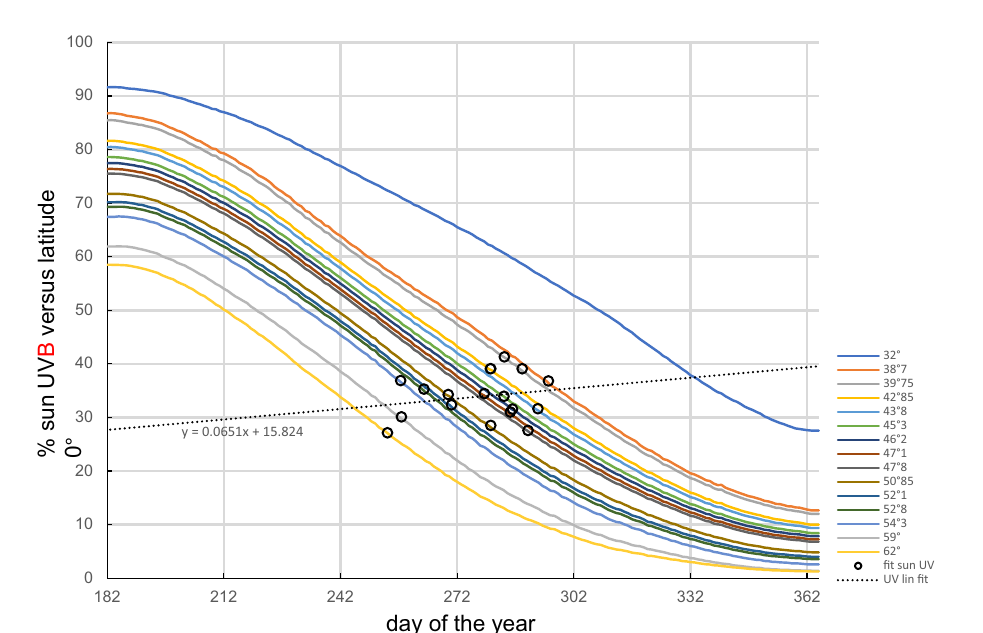
Figure 3. COVID-19 surge date as a function of country mean temperature (A) and humidity (B) during the 2 preceding weeks and as a function of country PWC latitude (C) , pointing to vitamin D as one of the primary factors (flags link countries between graphs).